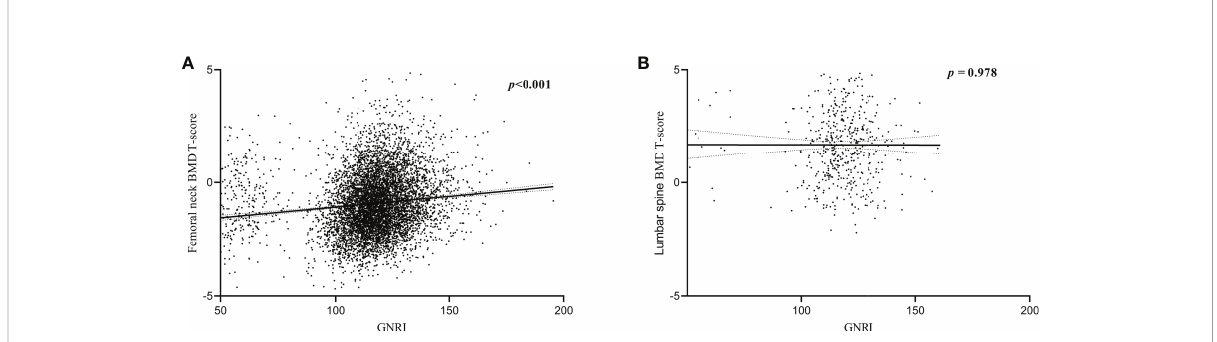
FIGURE 3 Correlation between BMD T-scores and GNRI. (A) Correlation between femoral neck BMD T-scores and GNRI. (B) Correlation between lumbar spine BMD T-scores and GNRI.